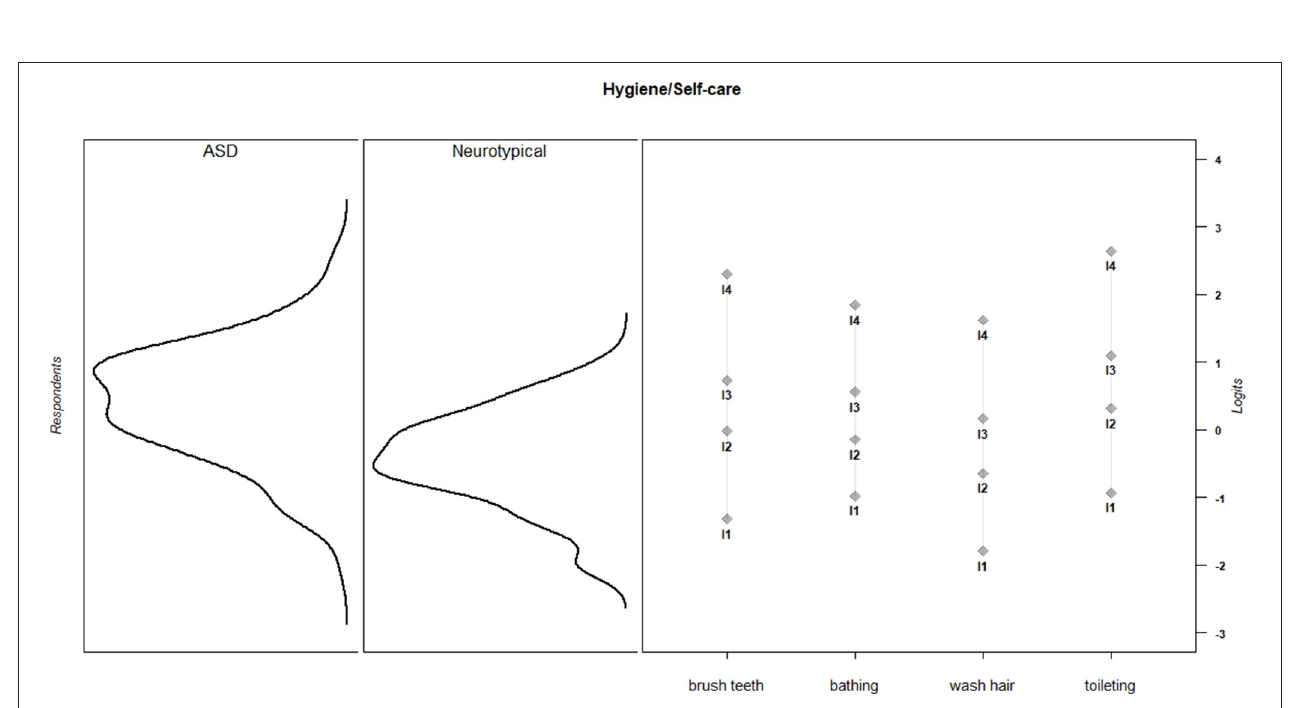
FIGURE 2 | Hygiene/self-care item parameters and person parameters by